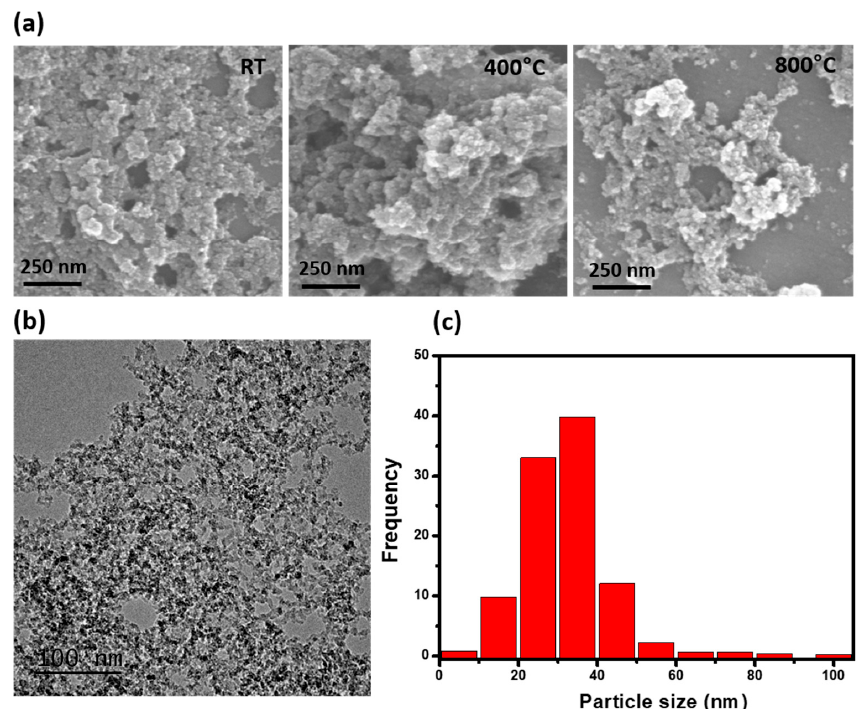
Figure 3. ( a ) SEM and ( b ) TEM images of aBC generated at various treatment temperatures, and ( c ) average particle size distribution for synthesized aBC.